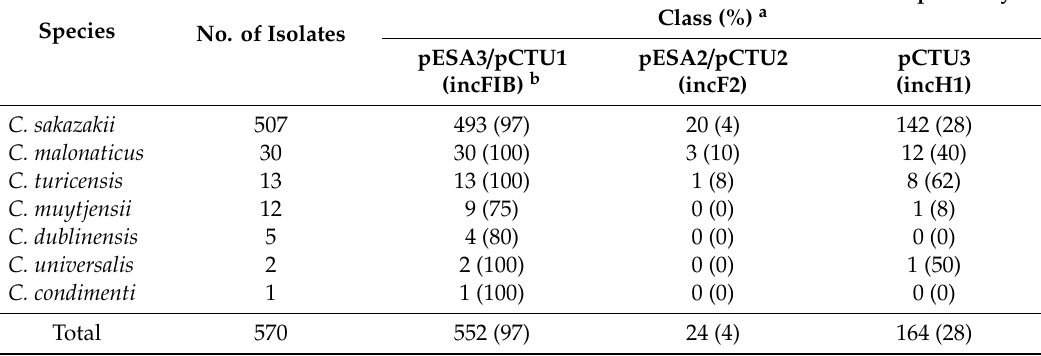
a Numbers within parentheses are the percentage PCR-positive for each plasmid replicon gene locus ( repA ) as described by Franco et al. [47]. The prevalence of pESA3 / pCTU1 (incFIB), pESA2 / pCTU2 (incF2), and